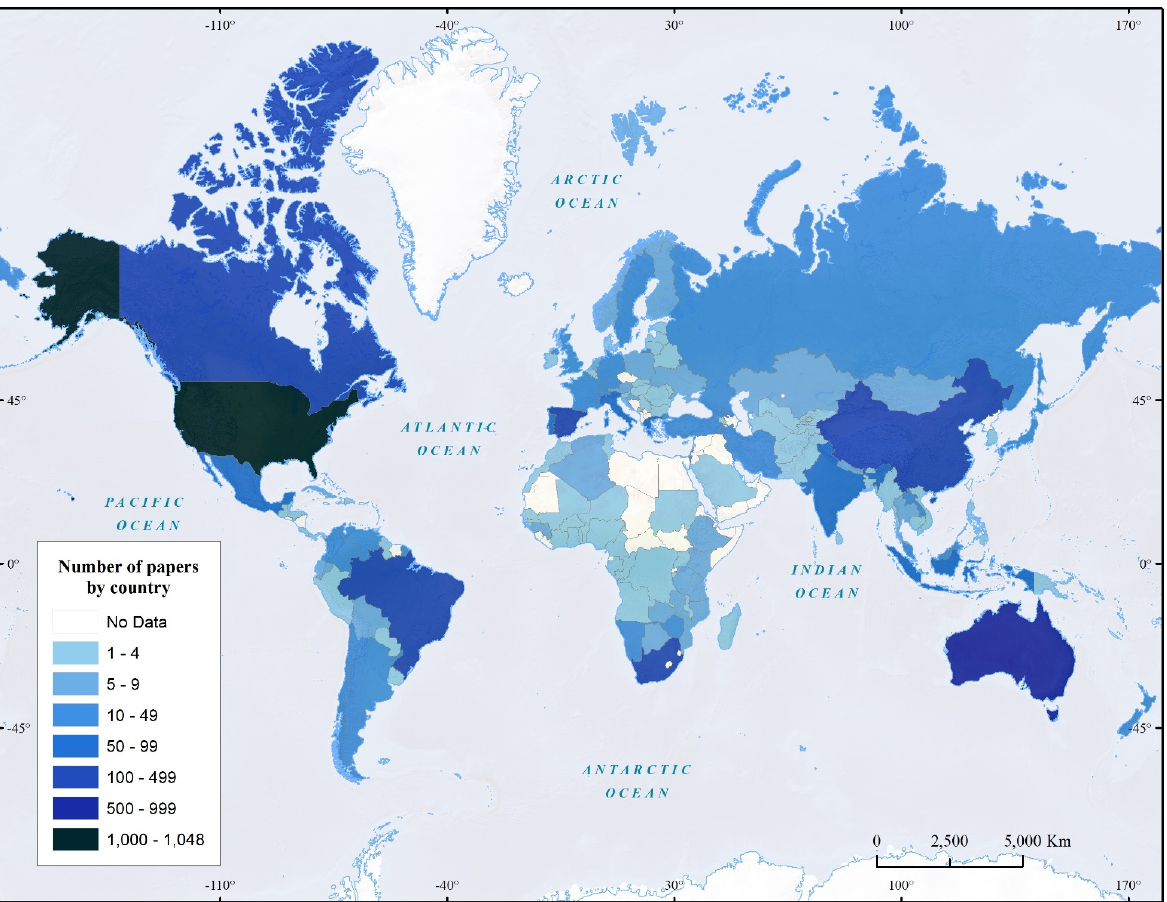
Figure 5. Publications listed in Scopus (1973–2021) per country in terms of spatial focus